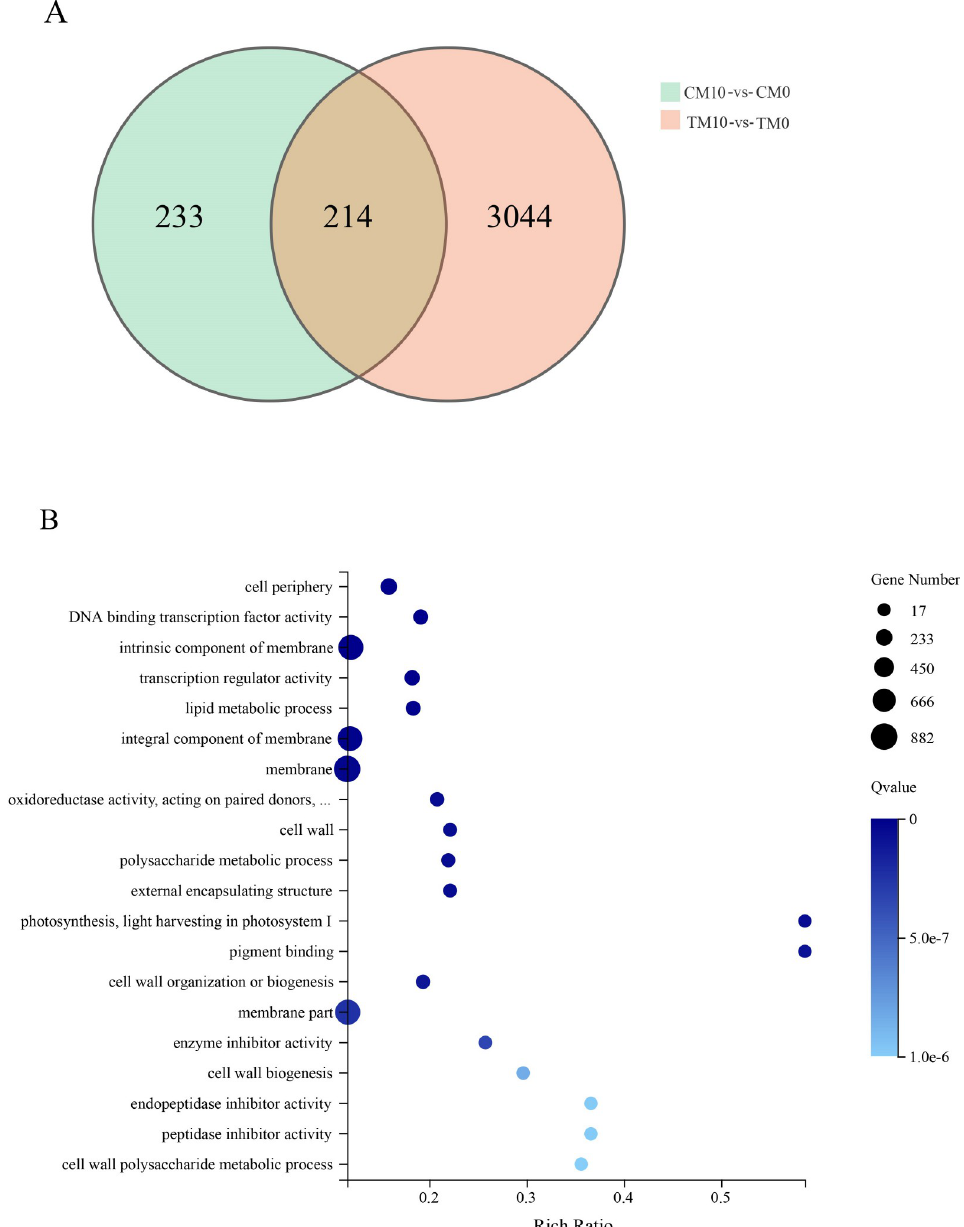
Fig 8. Analysis of DEGs specific to melatonin treatment under drought condition. A. comparative analysis of DEGs between TM10-vs-TM0 and CM10-vs-CM0 comparison groups. The green circle represents DEGs in CM10-vs-CM0, and the red circle represents DEGs in TM10-vs-TM0. B. 3044 DEGs specific belonging to TM10-vs-TM0 were analyzed by GO enrichment and displayed by bubble